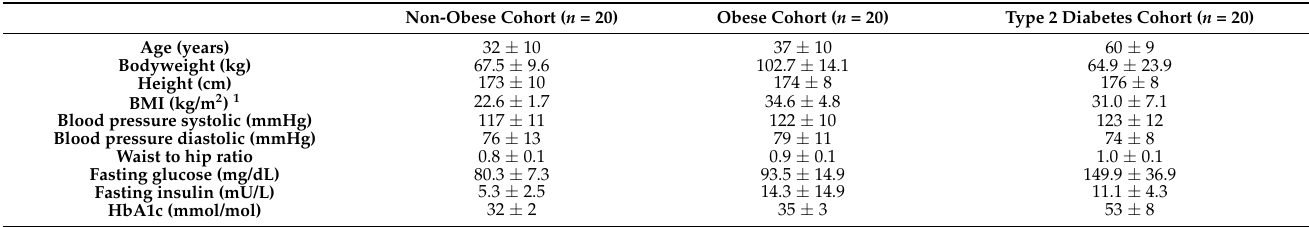
Table 1. Baseline characteristics of non-obese and obese participants and patients with type 2